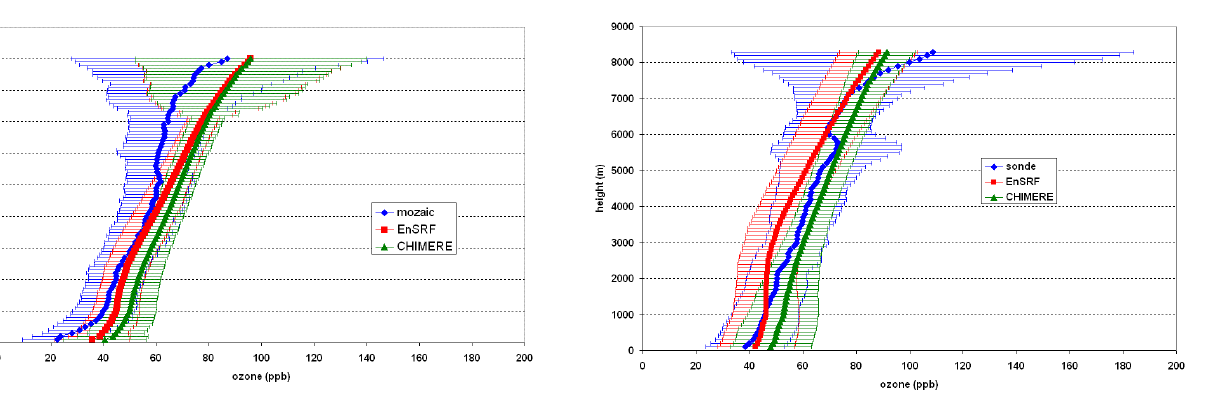
Fig. 11. Same comparison as in Fig. 10 using an average profile Figure 11. Same comparison as in Figure 10 using an average profile calculated for the 46 calculated for the 46 soundings available (for information about the soundings available (for information about the five locations, see Table2). five locations, see Table